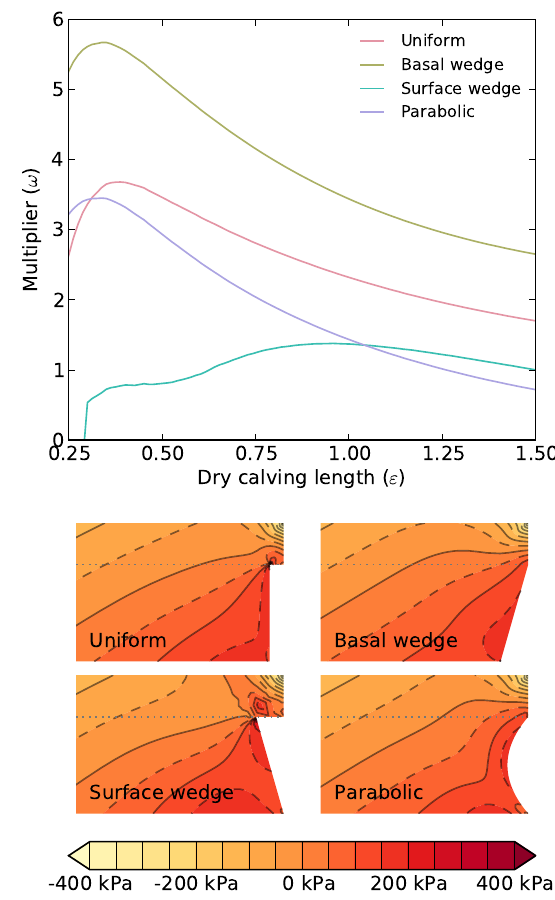
Fig. 8. Above: the ω − ε relationship for a variety of frontal melt pro- files ( h = 0 . 7). Below: Cauchy stress fields (relative to hydrostatic pressure) associated with frontal melt